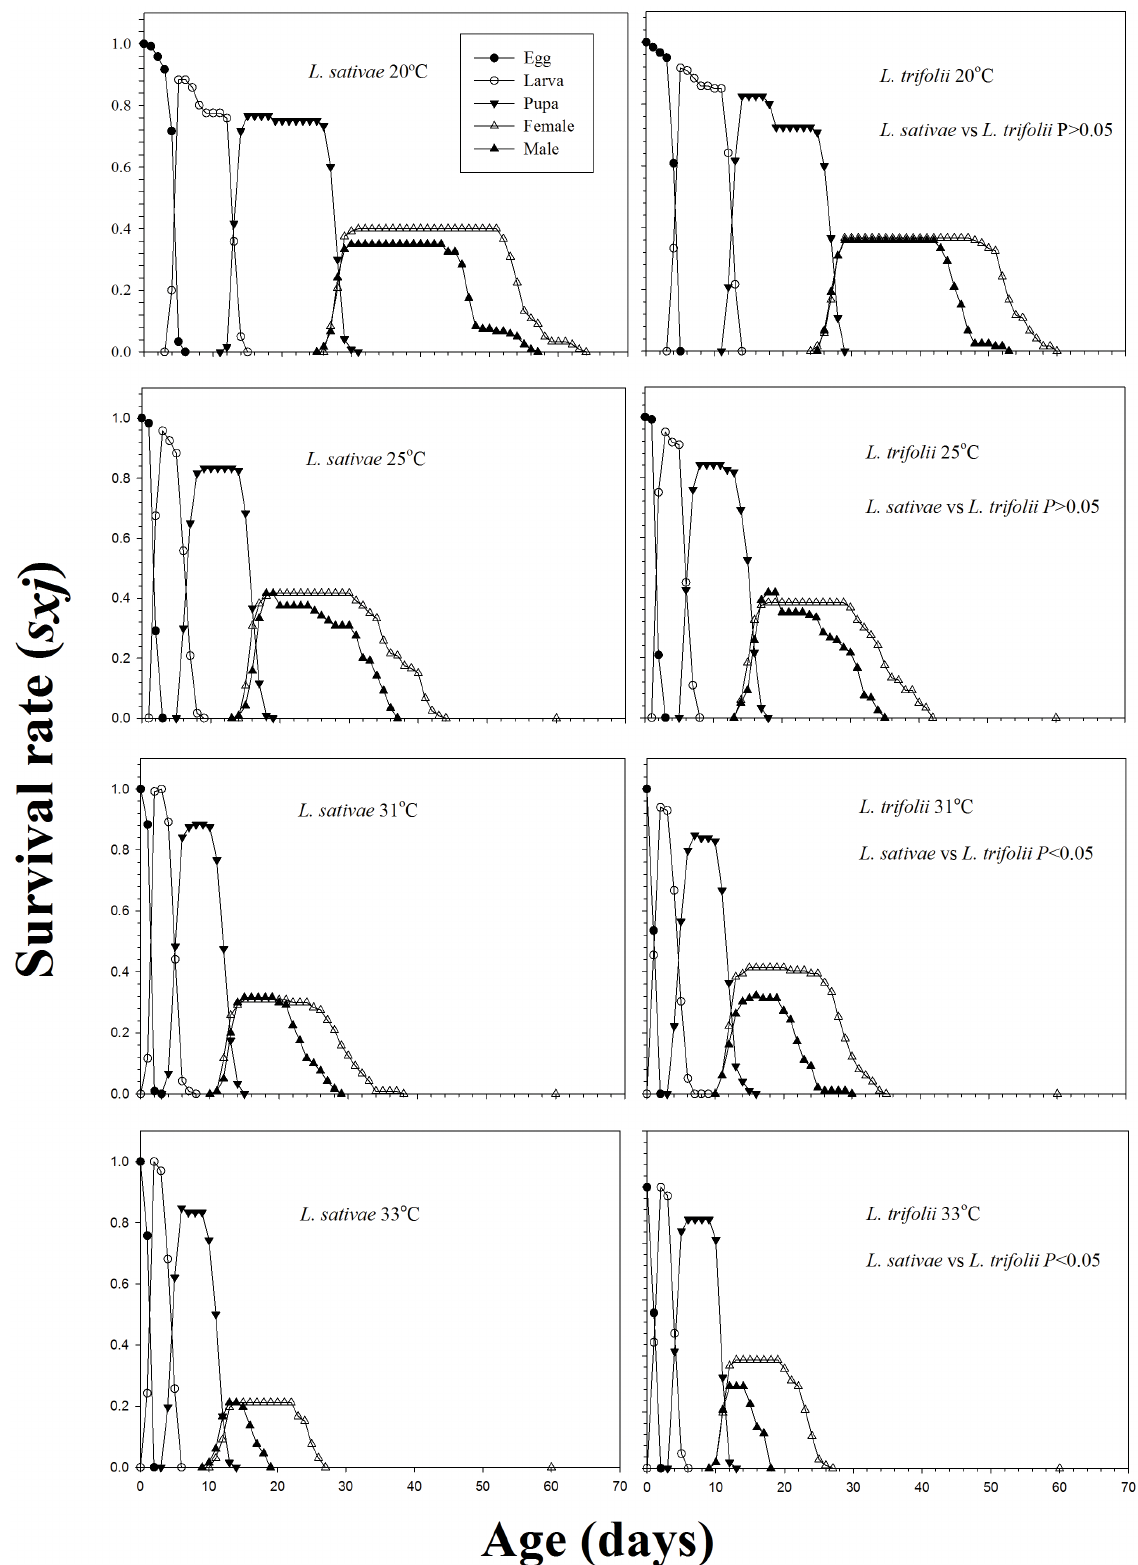
Figure 1. Age-stage specific survival rate ( s xj ) of Liriomyzasativae and L.trifolii under different constant temperatures.